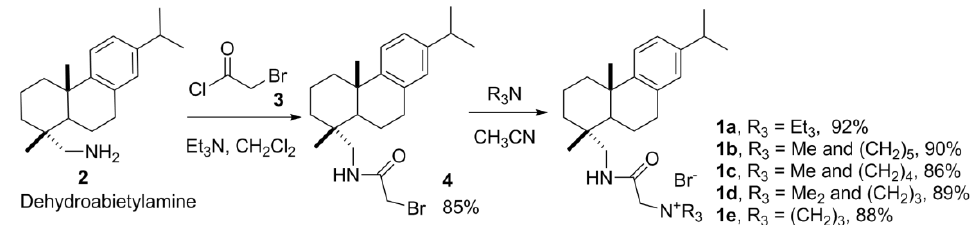
Scheme 1. Synthesis of chiral dehydroabietylamine quaternary ammonium